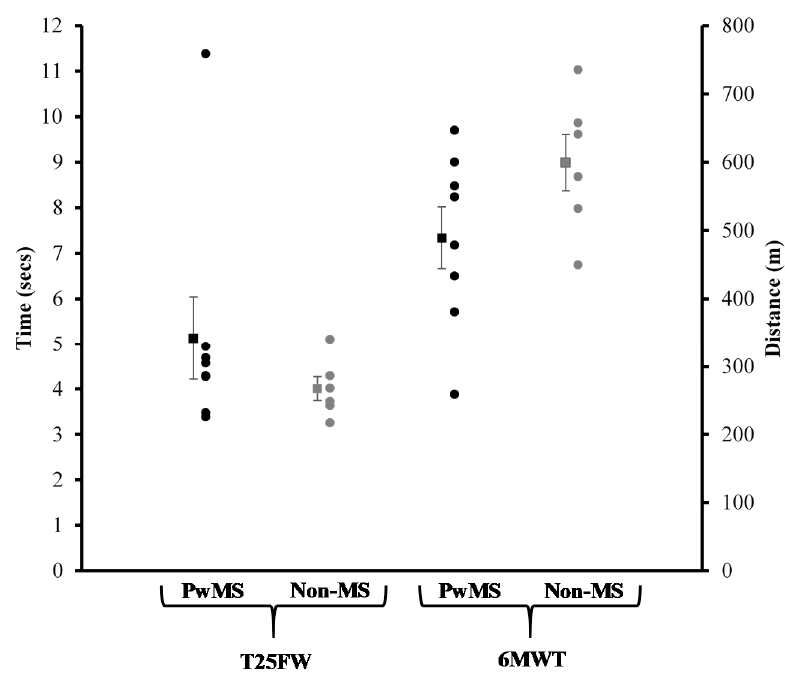
Figure 2. Walking capacity assessments. Data are presented as mean ± SE.